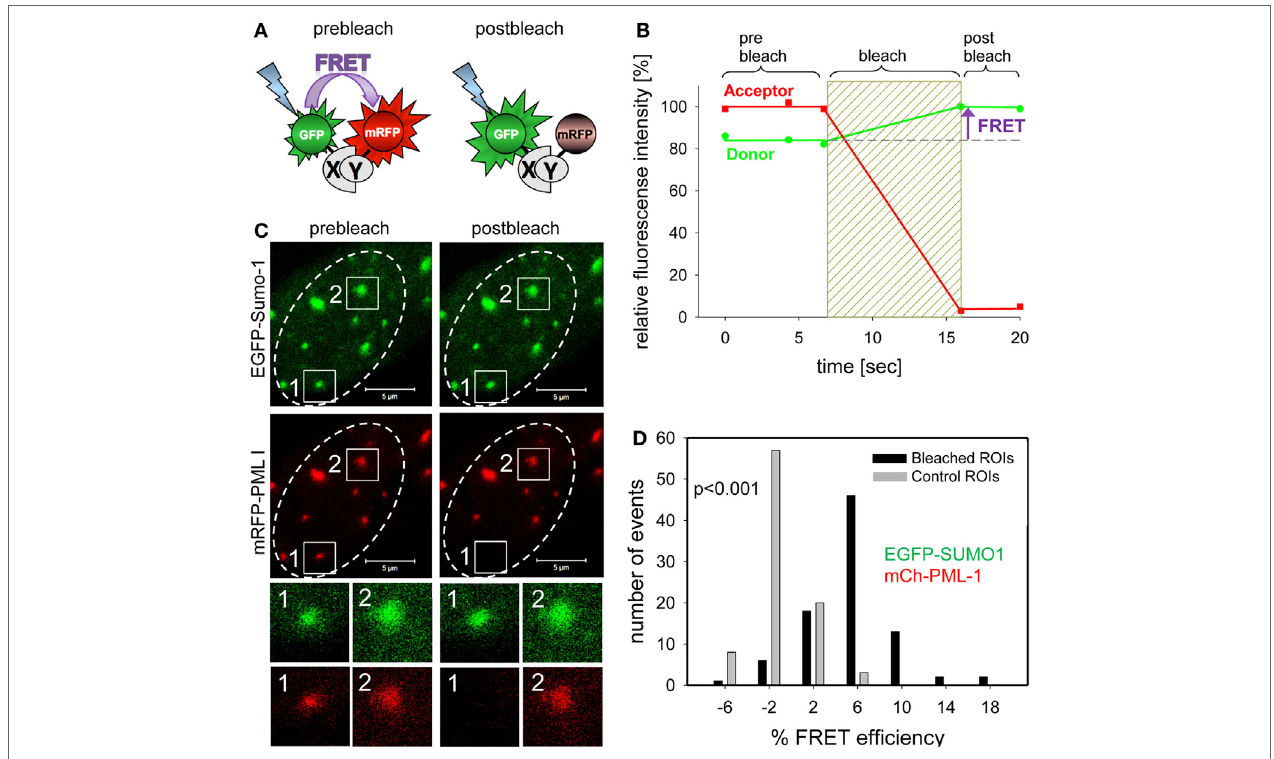
FigURe 7 | Complex formation assessment of promyelocytic leukemia (PML) body components by acceptor-photobleaching Förster resonance energy transfer (FRET). (A) Schematic explanation of acceptor-photobleaching Förster resonance energy transfer (abFRET). The energy donor EGFP and the energy acceptor mRFP are fused to proteins X and Y, which are sufficiently close ( < 10 nm) to each other to allow for FRET. Left side: the acceptor mRFP absorbs radiation-free energy from the exited donor EGFP resulting in decreased donor fluorescence intensity. Right side: acceptor mRFP is bleached and energy is no longer transferred from donor EGFP to acceptor mRFP resulting in an increase of donor fluorescence intensity. (B) Time courses of the fluorescence intensity of donor and acceptor during abFRET. Bleaching of the acceptor results in a fluorescence intensity increases of the donor indicating FRET (arrow). (C) Cell nucleus showing the location of EGFP-Sumo-1 and mRFP-PML I in PML-bodies. Two of them, spot1 and spot2, were selected for fluorescence intensity analysis before and after acceptor- photobleaching (see enlargements below). At spot 1, the acceptor fluorophore mRFP was bleached (compare prebleach and postbleach), whereas spot 2 was not bleached and served as control. (D) The donor fluorescence intensity variation observed during acceptor-photobleaching was determined for 89 not bleached control PML-bodies (see spot 2) yielding E var (gray bars) and for 89 acceptor-photobleaching PML bodies (see spot 1) yielding E FRET (black bars). The numbers of observed single cases (grouped into E var or E FRET value ranges of 4%) are displayed versus the values of E var and E FRET